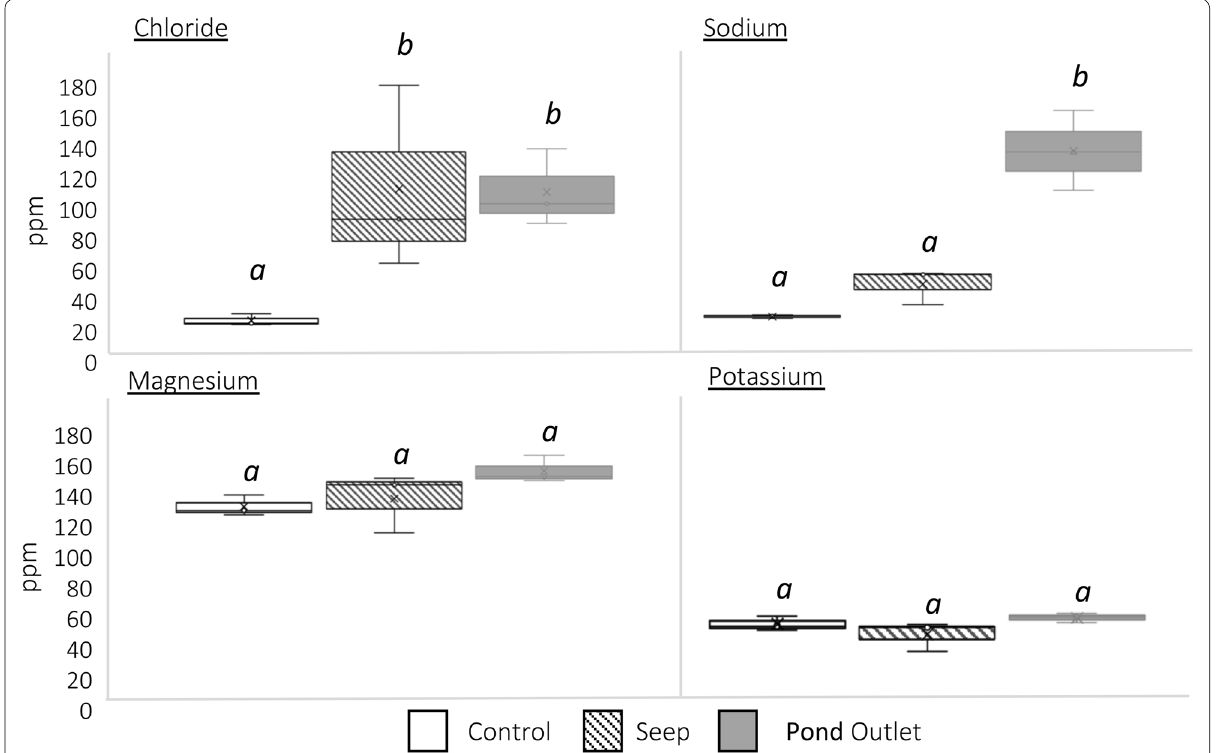
Fig. 4 Soil nutrient concentrations of chloride, sodium, magnesium, and potassium at the “Control,” “Seep,” and “Pond Outlet,”